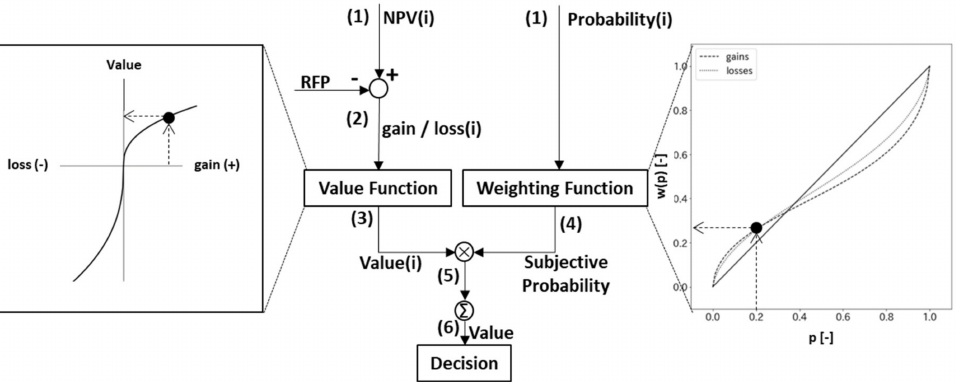
Figure 4. Calculation process of the VRE investment value in STEP IV: (1)–(6) correspond to the numbers in the description of STEP VI. The black dots in the graphs are